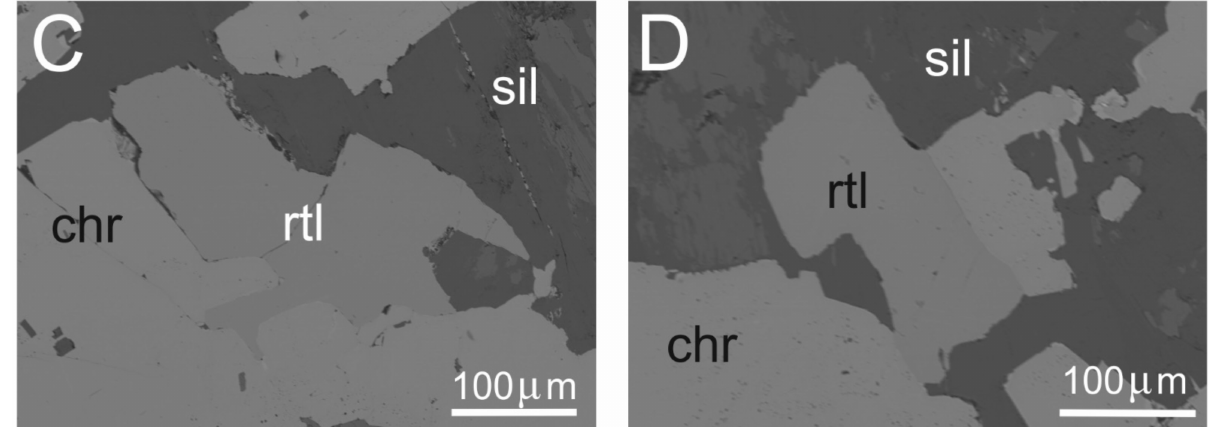
Figure 7. Texture typology of rutile associated with the metamorphic chromitite of Nuasahi (BSE images). Large, anhedral rutile grains associated with recrystallized and altered chromite (sample NS9) ( A , B ). Note the acicular rutile inclusions in chromite ( B ). Large, anhedral rutile grains at the boundary chromite-silicate (sample NS9) ( C , D ). Abbreviations as in Figures 1, 4 and 6.